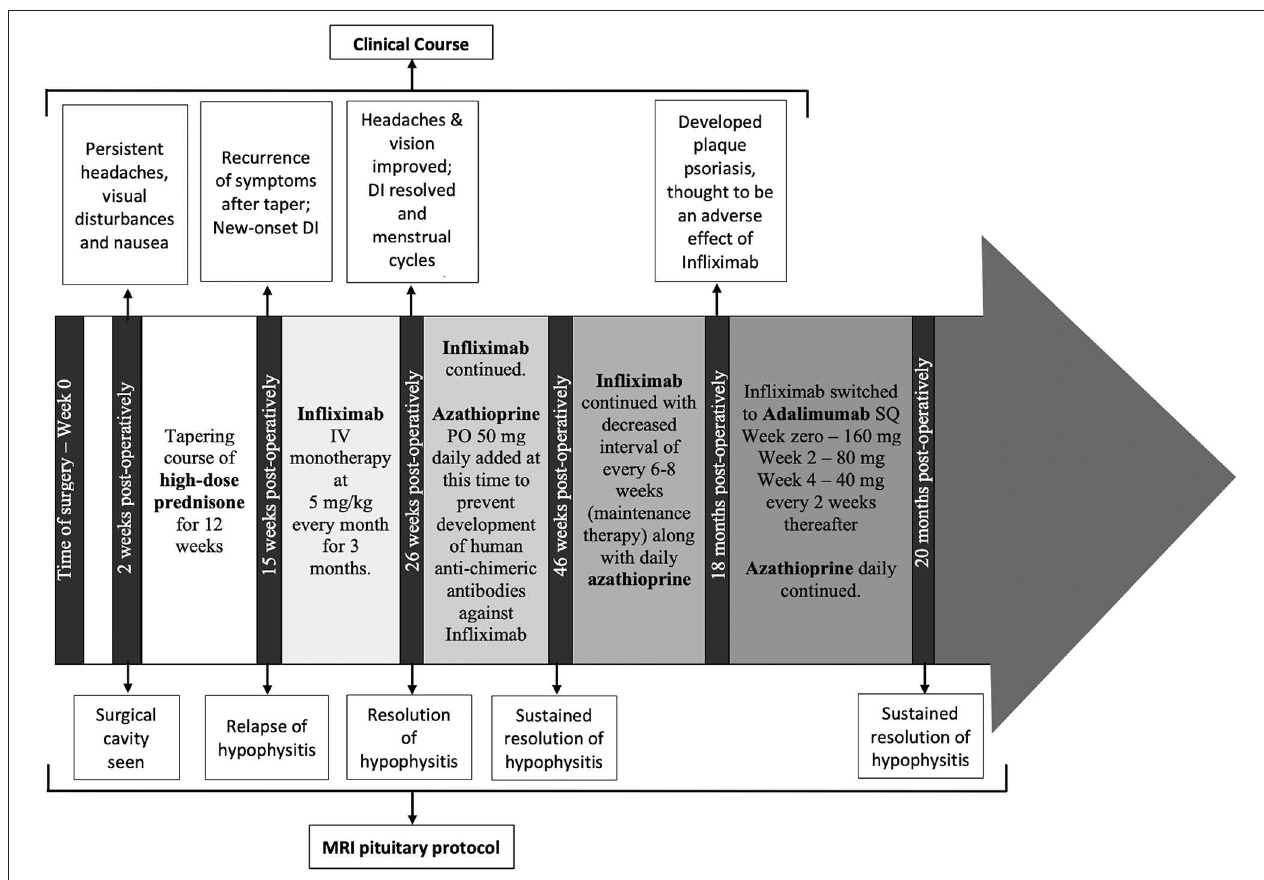
FIGURE 3 | The timeline of the patient’s clinical course, treatment and MRI monitoring are shown from the time of surgery (0 weeks) through to the most recent imaging at 20 months from surgery.